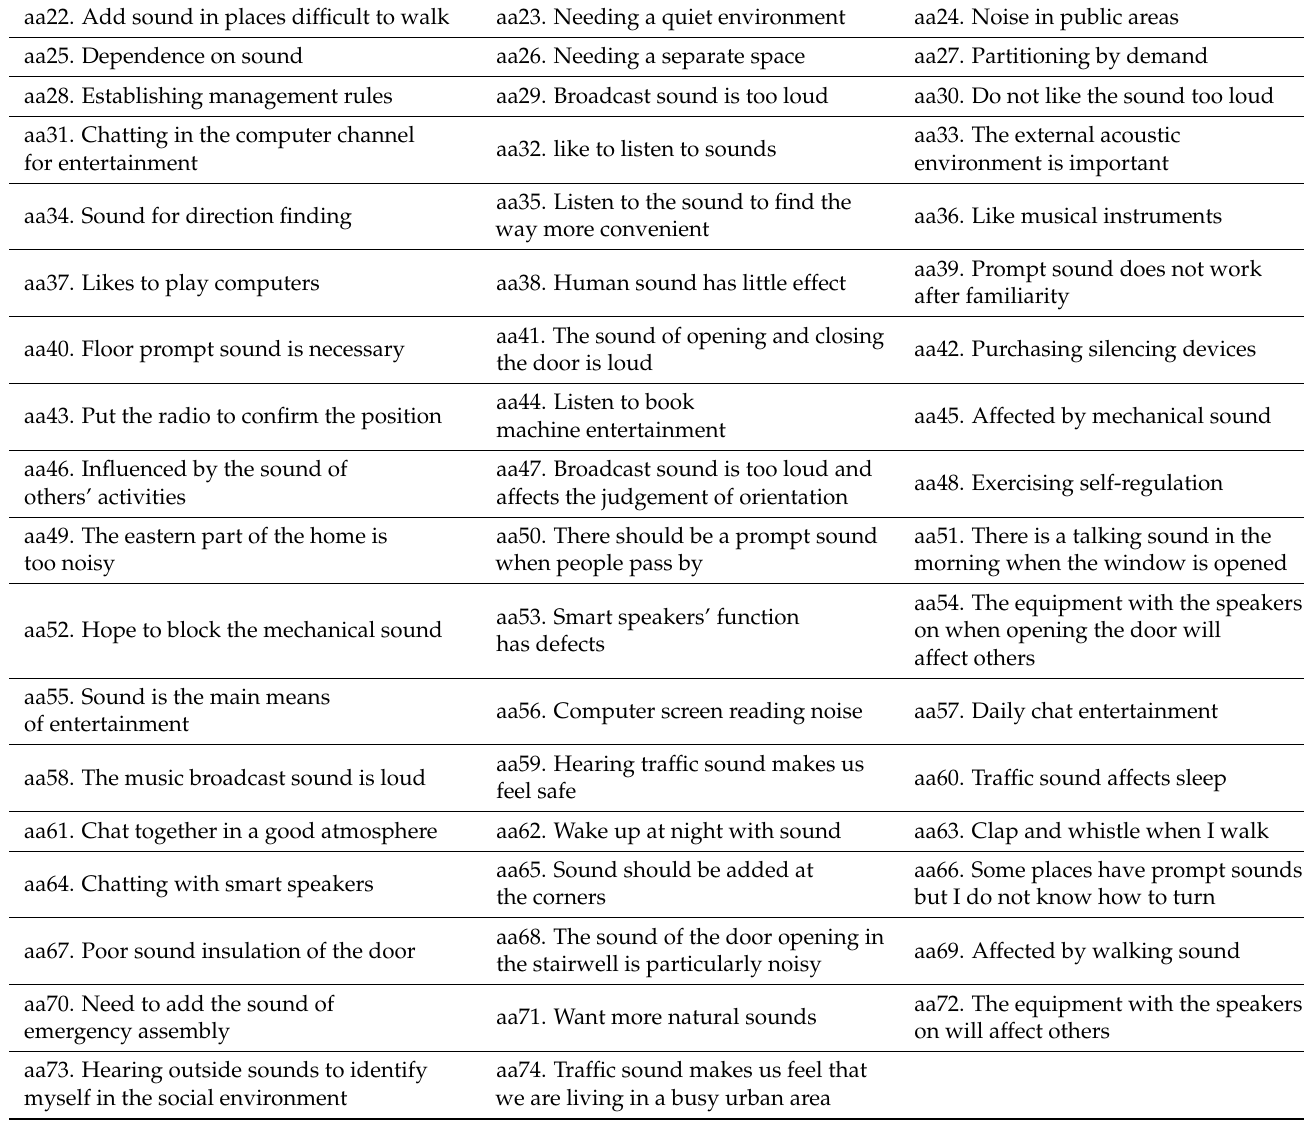
Table A1. The rest of the labels in the open